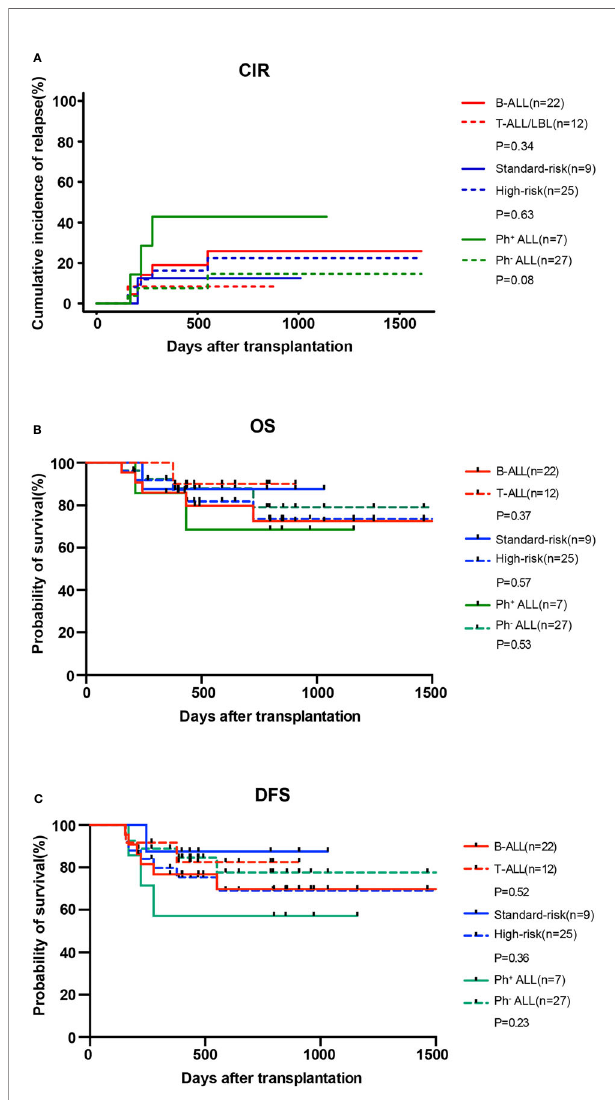
FIGURE 3 | CIR (A) and OS (B) and DFS (C) for patients with B-ALL (n = 22) and T-ALL/LBL (n = 12), patients at high risk (n = 25) and standard risk (n = 9), and patients with Ph + ALL (n = 7) and Ph − ALL (n = 27) after